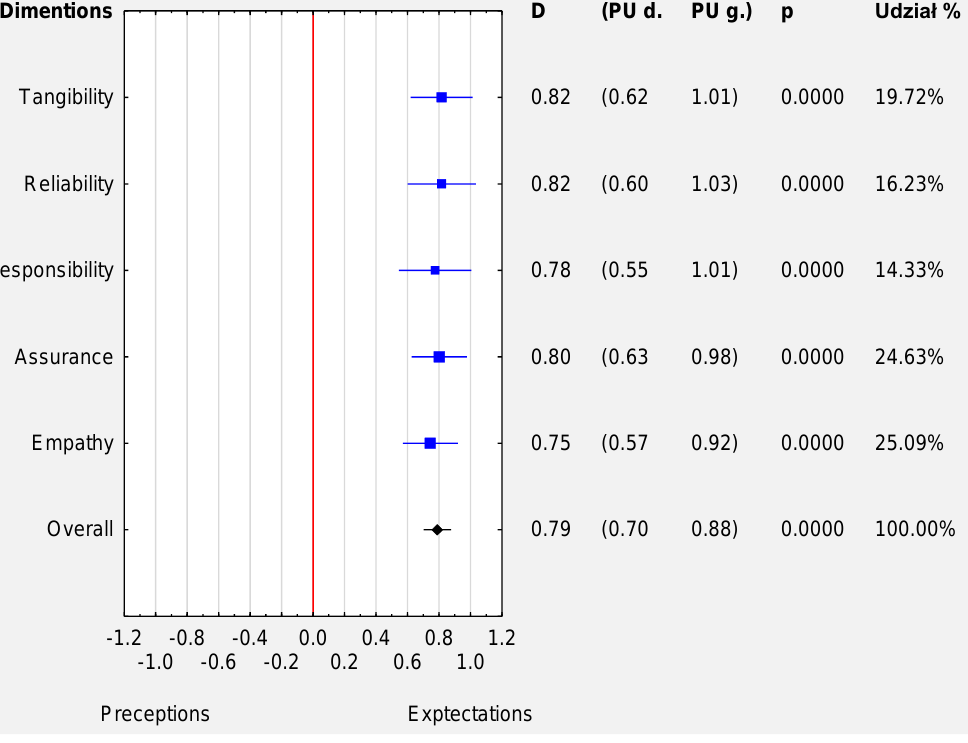
Figure 7. Forest plot for the mean difference ([ MD]; 95% CI) of the patients’ perceptions and expec- tations in all dimensions.